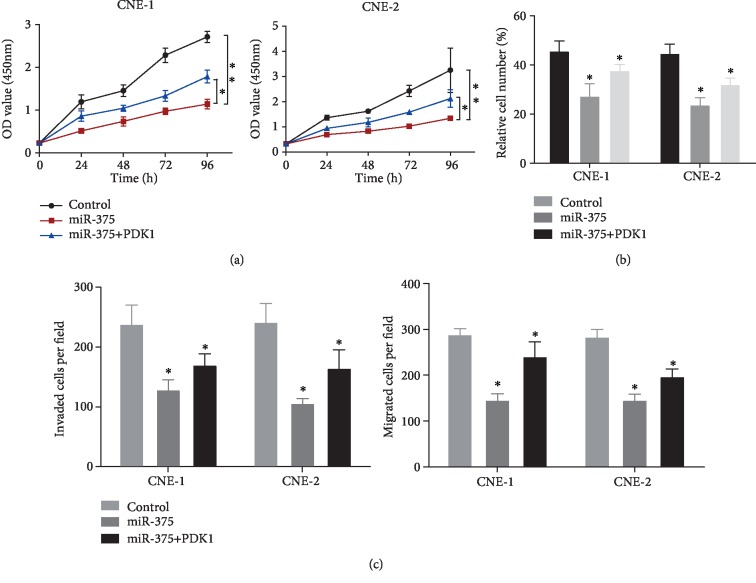
qRT-PCR and Western blot were carried out to measure levels of PDK1 in CNE-1 and CNE-2 cells. (a–c) We quantified migration, invasion, progression through the cell cycle, and apoptosis in both transfected cell lines. Con group: transfection with competing and empty vector; miR-375 group: transfection with miR-375 mimic and empty vector; miR-375+PDK1 group: transfection with miR-375 mimic and overexpression of PDK1 plasmid. Data are displayed as average ± SD. Each experiment was repeated three times.